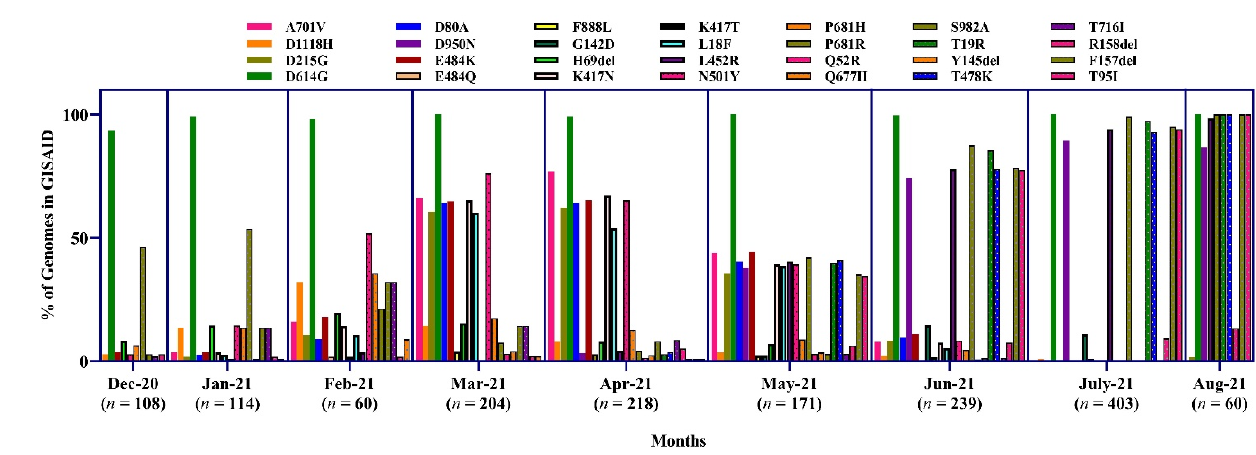
Figure 12. Proportion of amino acid mutations in the spike protein of SARS-CoV-2 sequences in Bangladesh.